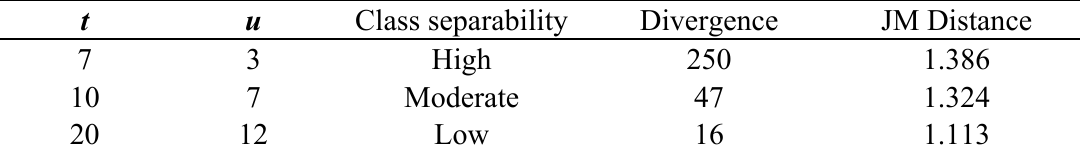
Table 3. Parameters used to create the three groups of varying class separability for the radiometric normalization experiment.